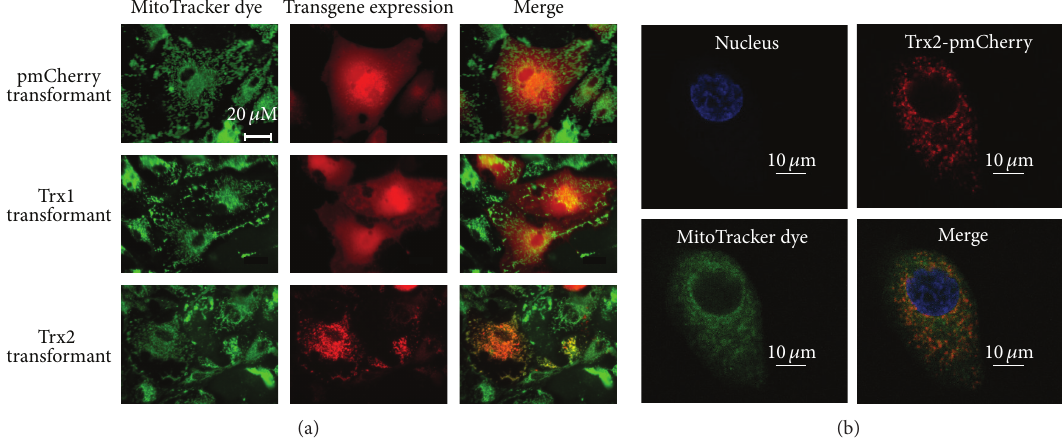
Figure 2: Expression profile of Trx1 and Trx2 in ARPE cells. ARPE cells were infected with AAV-Trx1 or AAV-Trx2, and Trx-overexpressing cells were established (ARPE-Trx1, ARPE-Trx2). The expression of Trx1 and Trx2 is indicated by the fluorescence of the reporter protein pmCherry, which was fused to Trx. Localization of Trx2 to mitochondria was examined by the fluorescence of a mitochondrial marker dye. ARPE cells infected with AAV-pmCherry served as a control. Fluorescence was observed using microscope (a) and confocal microscope (b).